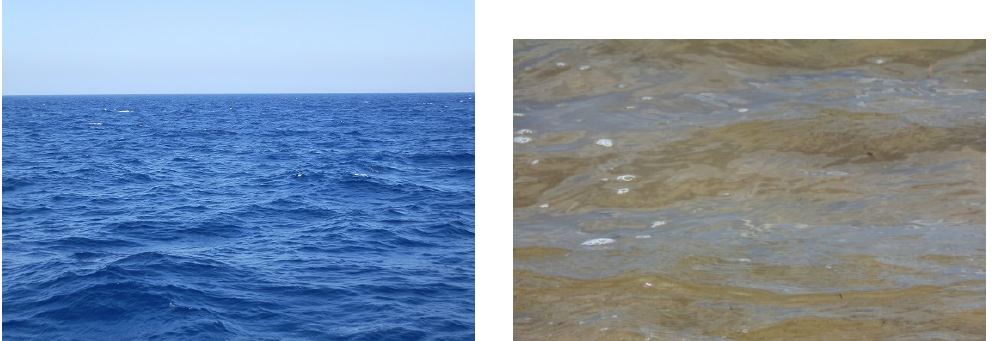
Figure 14. ( Left ) A picture of a typical sea state, with moderate wind. The surface appears disordered due to the propagation of numerous interacting waves of various scales. The wave turbulence theory proposes a quantitative description of this state, with the hypothesis of weakly nonlinear waves, negligible wind forcing, dissipation acting only at small scales, etc. However, we note the presence of sharp crested waves and of a few whitecaps (foam) at the top of some waves. ( Right ) A small-scale picture of surface waves. Capillary waves are superposed with the larger gravity waves and provide a small-scale